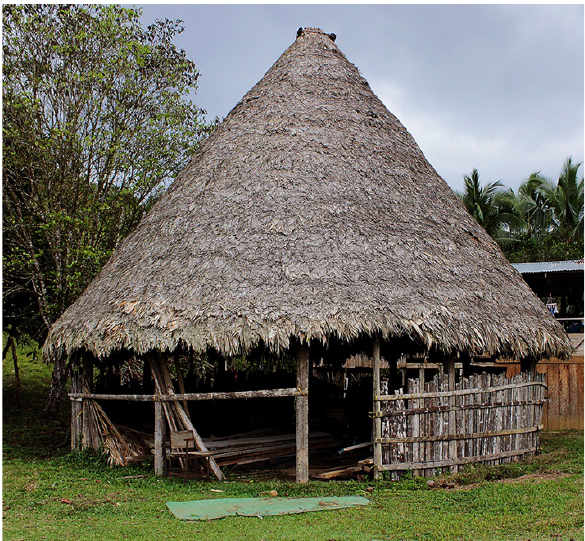
Figure 8. Primary school building in Sieikin, Naso territory.